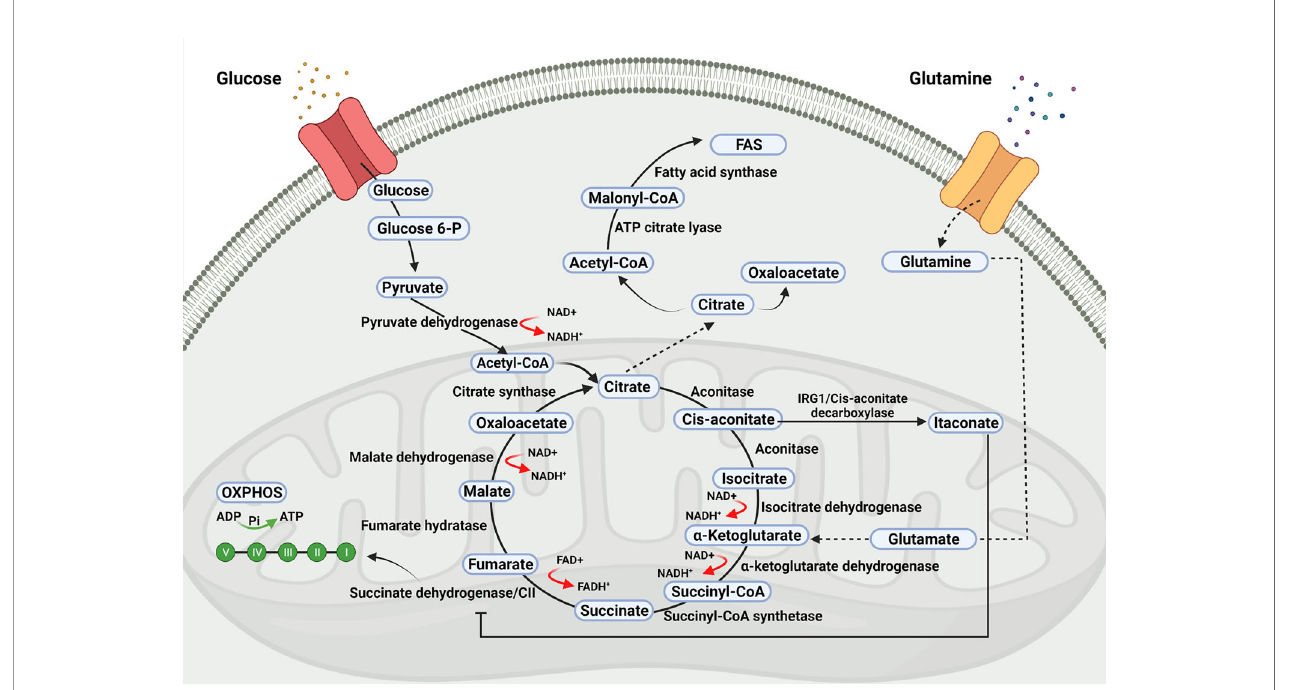
FIGURE 1 | Tricarboxylic acid (TCA) cycle. The TCA cycle takes place within the mitochondria and it is the source of precursors for the synthesis of biomolecules required for viral replication as well as of metabolites with signalling properties which may in fl uence the outcome of viral